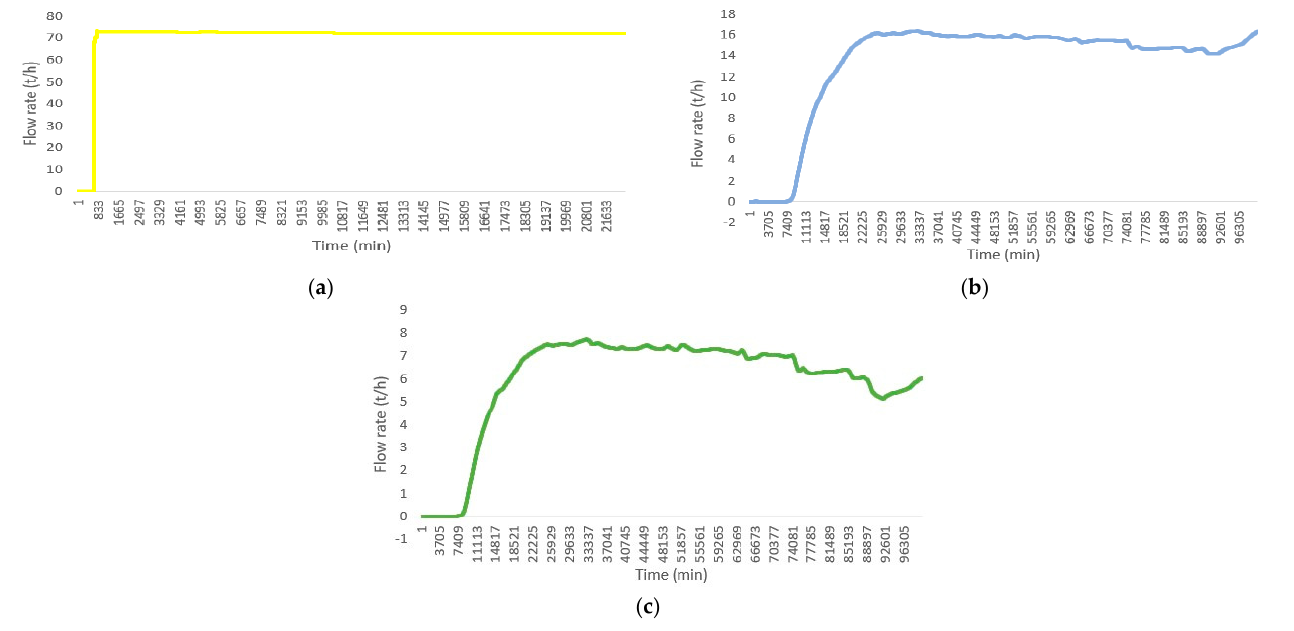
Figure 17. HP stage flow rate. ( a ) IP stage flow rate ( b ) exhaust flow rate ( c ) dynamic simulation.